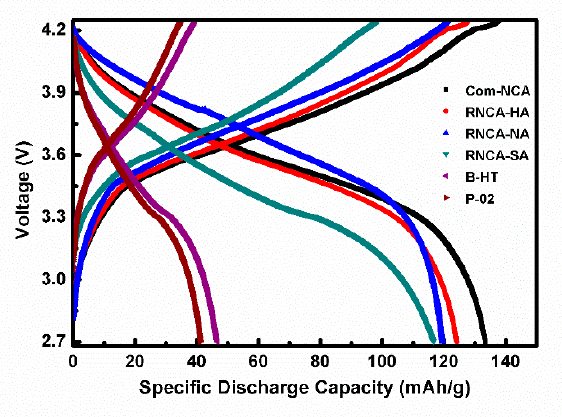
Figure 11. Specific Discharge Capacity of all RNCA samples at 0.02 C.